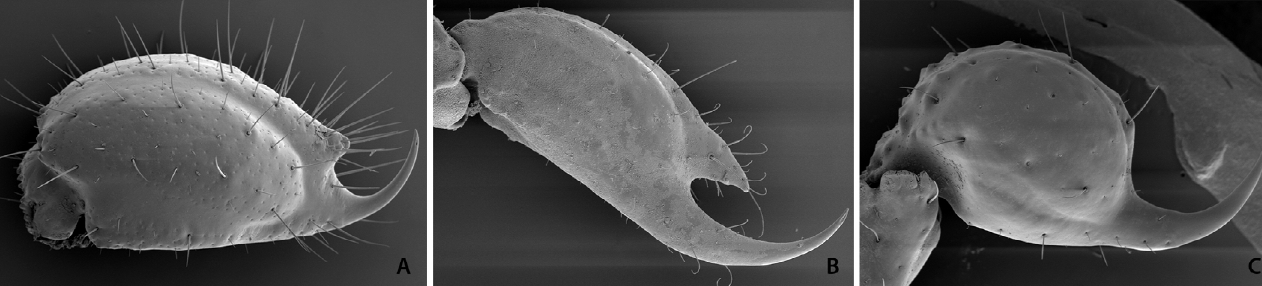
Figure 6. SEM images of telsons. (A) Didymocentrus lesueurii (Gervais) from Martinique Island, a Diplocentridae with a typical conic sub-aculear tubercle. (B) Himalayotityobuthus martensi Lourenço, Buthidae from Nepal with a huge sub-aculear tubercle. (C) Kraepelinia palpator (Birula), Buthidae from Iran with absence of a sub-aculear